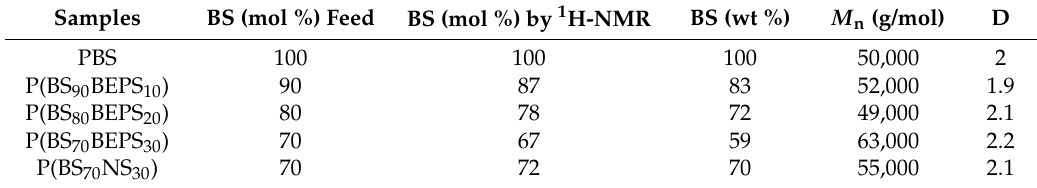
Table 1 . Molecular characterization data of PBS and P(BS m BEPS n ) and P(BS 70 NS 30 ) random copolymers. Samples